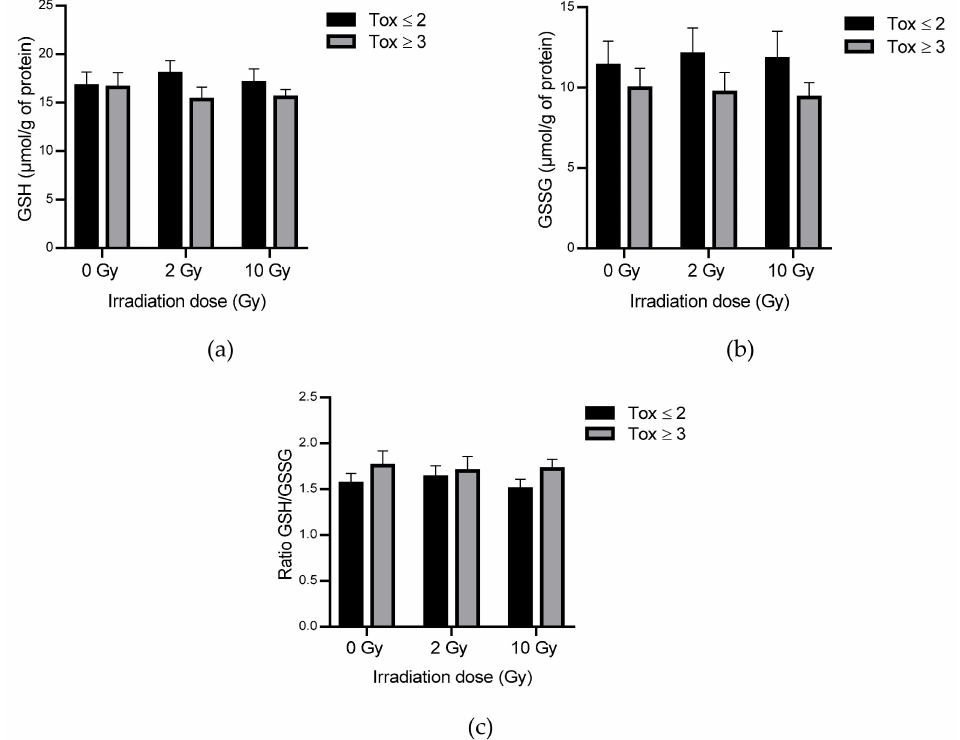
Figure 4. Reduced ( a ) and oxidized glutathione ( b ) and GSH (reduced glutathione) / GSSG (oxidized glutathione) ratio ( c ) in erythrocytes lysates in both groups of patients. Groups Tox ≤ 2 and Tox ≥ 3 correspond to patients presenting grade 2 or less and grade 3 or more of late skin reactions after radiotherapyaccording to RTOG / EORTC,